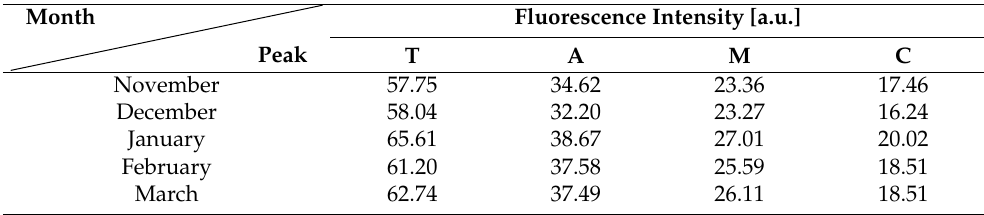
Table 6. Fluorescence intensity of detected peaks linked to their seawater components (T, A, M, C) for particular months in the winter season in the Baltic Sea (November–March). Month Fluorescence Intensity Peak